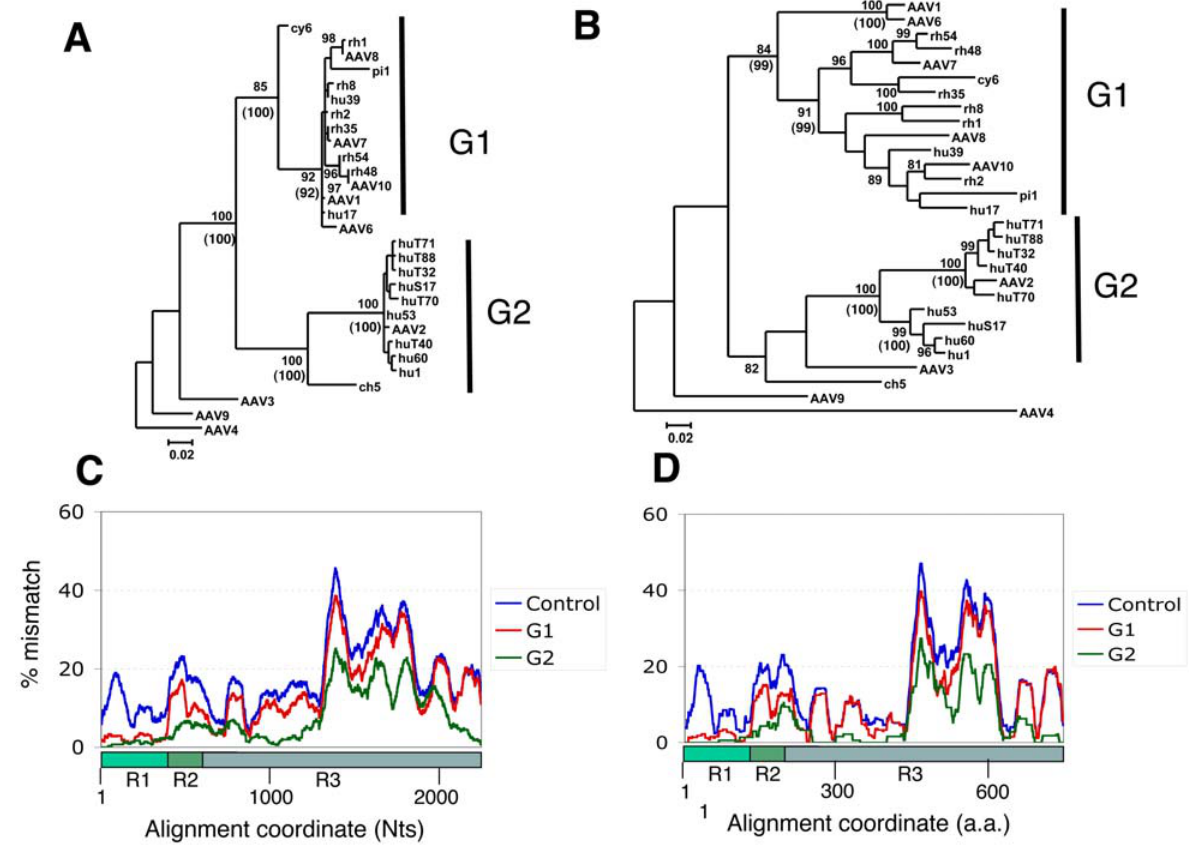
Figure 3. Identification of two sequence groups (G1 and G2) tightly clustered in the VP1 unique region. A. A Phyml maximum likelihood (ML) tree for R1 region was generated for a dataset of 29 sequences (see selection in Table S1). AAV4 was used as the outgroup and the bootstrap scores greater than 80 % are shown. Tightly clustered sequence groups, G1 of 15 sequences and G2 of 10 sequences, were identified and indicated. A similar tree was obtained using neighbour-joining method and its bootstrap scores that support G1 and G2 clustering are shown in parentheses. B. An ML tree for the full-length cap was obtained and shown in the same way as the R1 tree (Panel A). C. Average group LOHA profiles based on the nucleotide alignment are shown. Percent mismatch scores across a sliding window of 101 Nt positions for all possible pairs between all 29 sequences (Control), 15 G1 sequences (G1) and 10 G2 sequences (G2) were averaged and plotted against the nucleotide positions. D. Similar average LOHA profiles with 33 a.a. window size were obtained based on the amino acid sequence